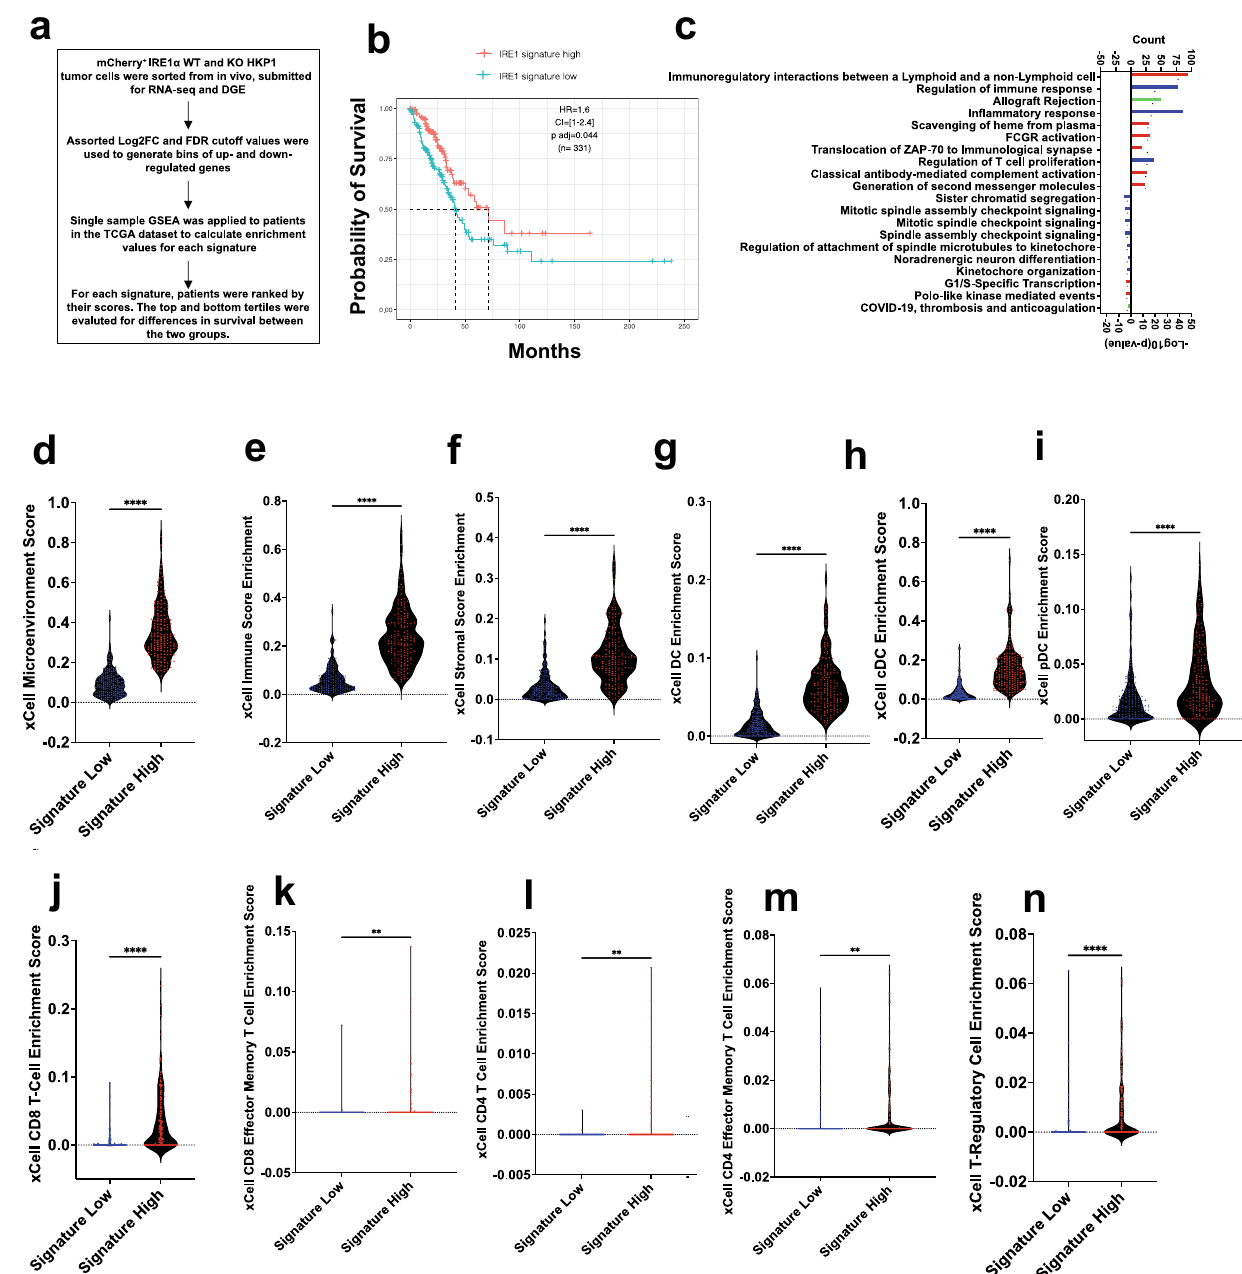
Fig. 5 | IRE1 α KO gene signature enrichment is associated with human LUAD survival and immune in fi ltration. a Schematic depicting IRE1 α signature gen- eration and evaluation. b Kaplan – Meier survival plots depicting associations between overall survival (OS) and IRE1 α KO signature status in human TCGA-LUAD. High is top 1/3rd ( n =166) and low is bottom 1/3 rd ( n =165) of the IRE1 α KO signature scores.HRisthehazardratioand p adjislog-rank p valuefromthemultivariateCox proportional-hazards regression model. c Gene ontologies between the IRE1 α KO signature high and low tertile patients. The count of genes enriching the term on the topx-axisisrepresented asabarplot, and the – log(10) p value for the termson